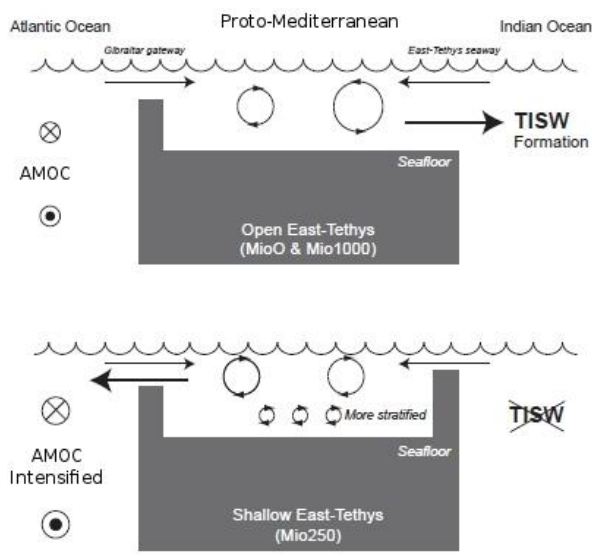
Fig. 6. Schematic view of oceanic circulation between the Indian Ocean, the proto-Mediterranean and the Atlantic Ocean when the eastern Tethys seaway is deep open (top panel) and when it is shal- low (bottom